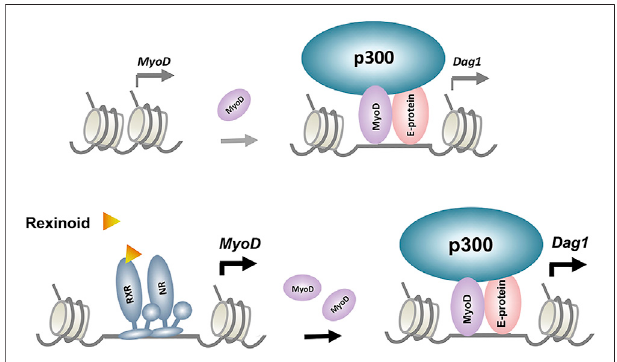
FIGURE 5 | Model proposed for the regulatory events underlying p300 and MyoD-mediated rexinoid signaling in Dag1 gene expression. RXR and its dimerizationpartner,nuclearreceptor(NR),enhance MyoD expression,which in turn augments target gene expression such as Dag1